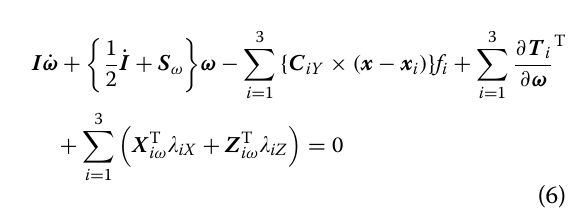
Fig. 11 Numerical analysis of the change in distance between each point marker: the distance between each point marker is spread on both sides when an external force acts on the fingertip